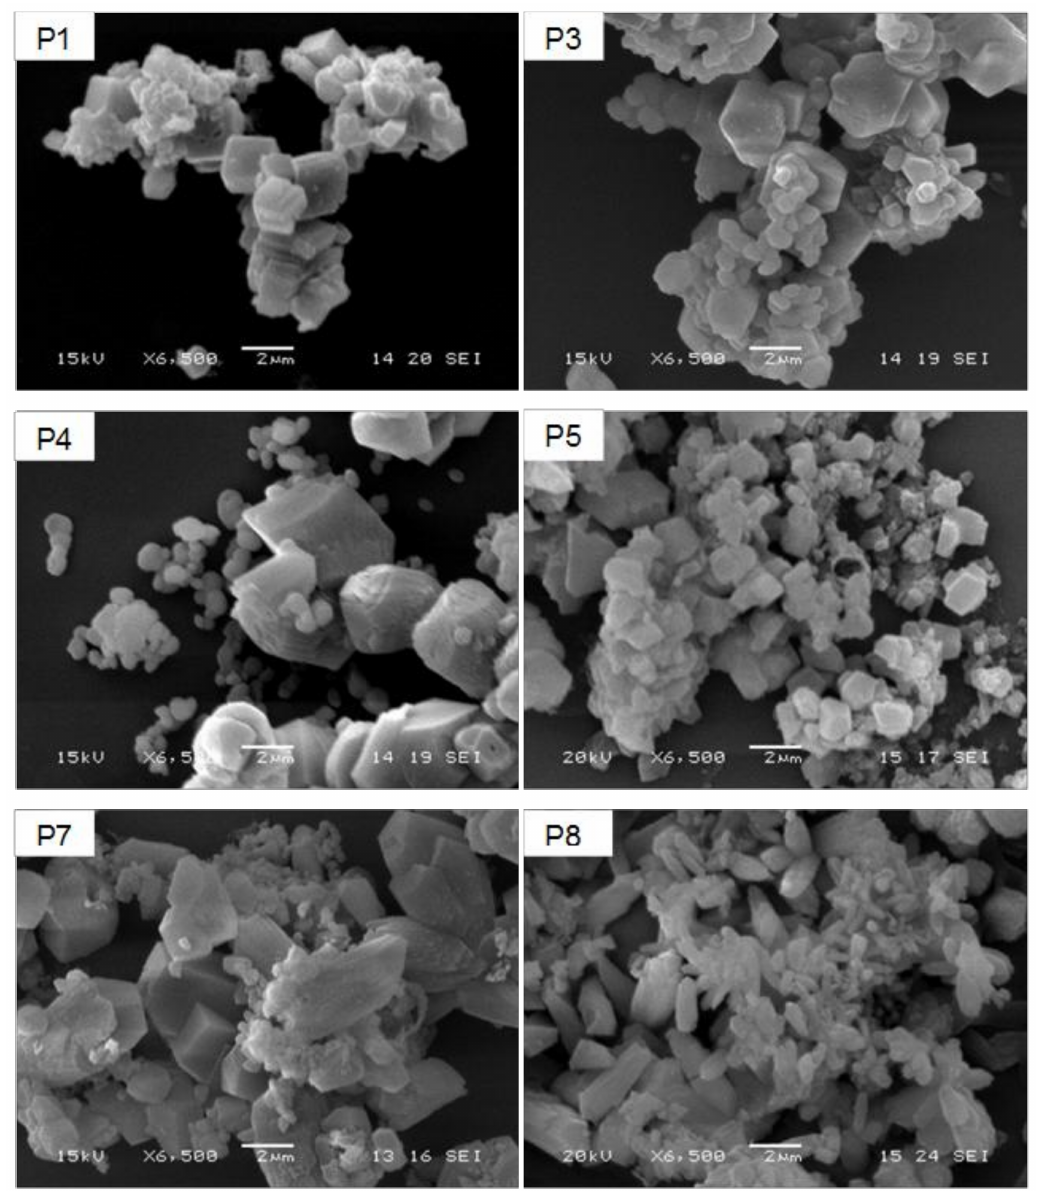
Figure 2. SEM micrographs of micrometer-sized precipitated CaCO 3 particles as obtained from the P1, P3, P4; P5, P7 and P8 preparation